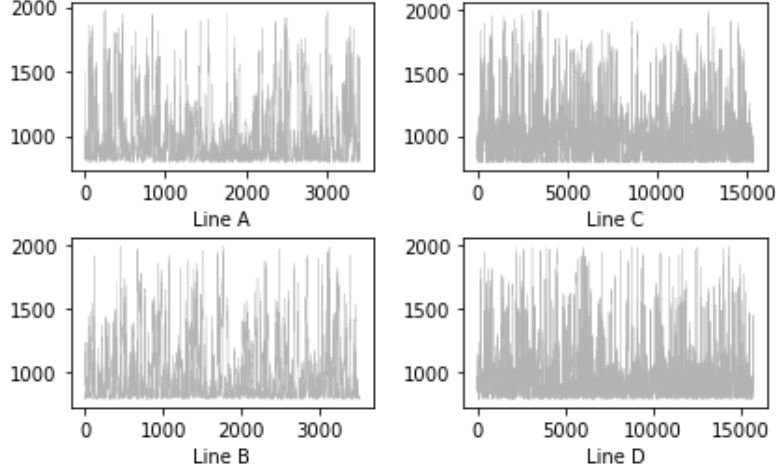
Figure 2. Cycle time (in seconds), per line.